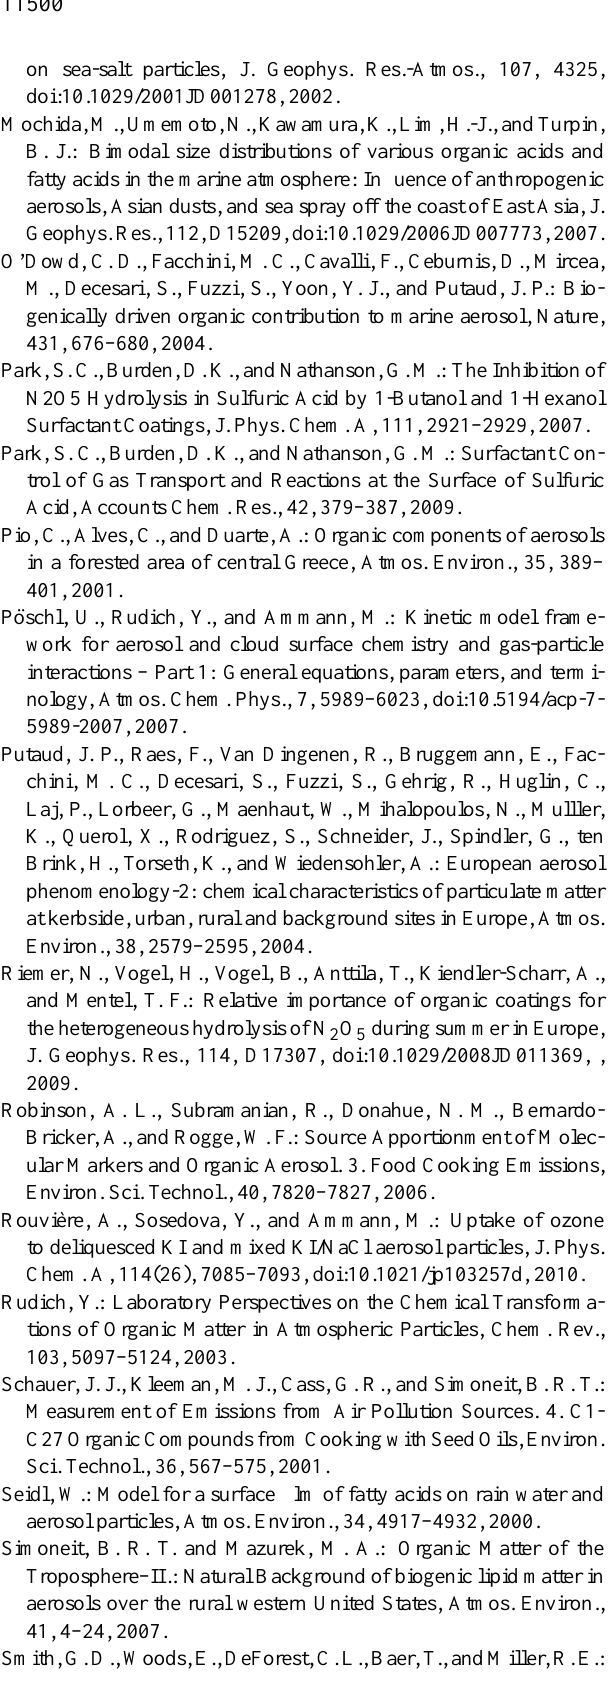
Tabazadeh, A.: Organic aggregate formation in aerosols and its